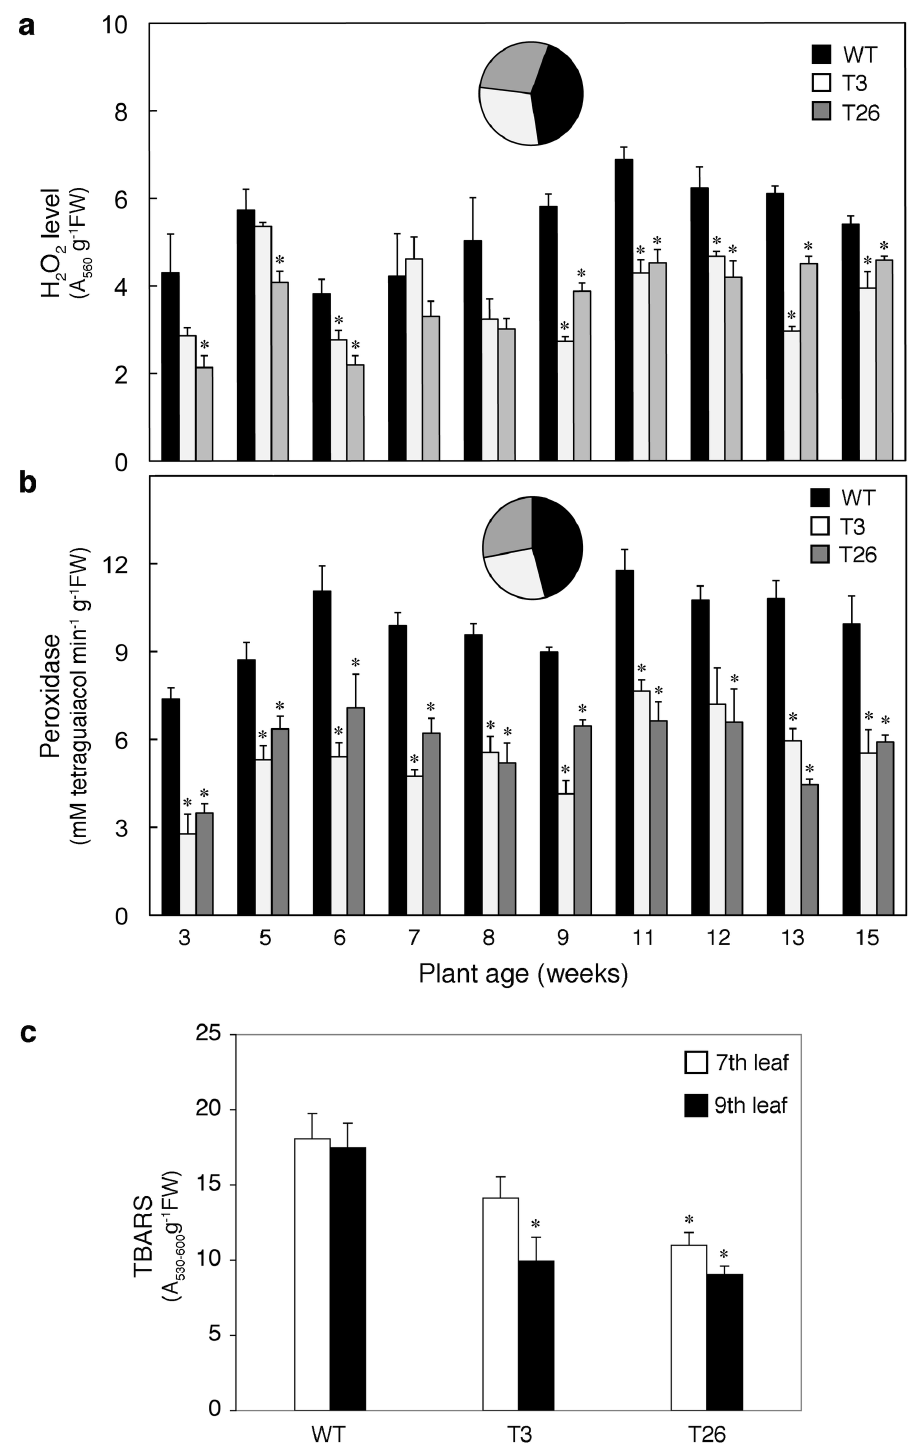
Figure 3. msrA3 -transgenic plants have lower basal oxidative stress level. (a) Relative level of H activity at different times during the growth of wild-type and transgenic plants. For (a) and (b), the bars represent means + SE (n=3). The Pie insets represent the average distribution of data in WT, T3 and T26. (c) Lipid peroxidation measured as TBARS in wild-type and transgenic leaves. The leaves were counted from the top and sampled from 11-week old plants. Bars represent means + SE (n=4). * p < 0.05 and **p < 0.1 refer to comparison between WT and transgenic (T3 or T26) leaves. doi: 10.1371/journal.pone.0077505.g003 PLOS ONE |